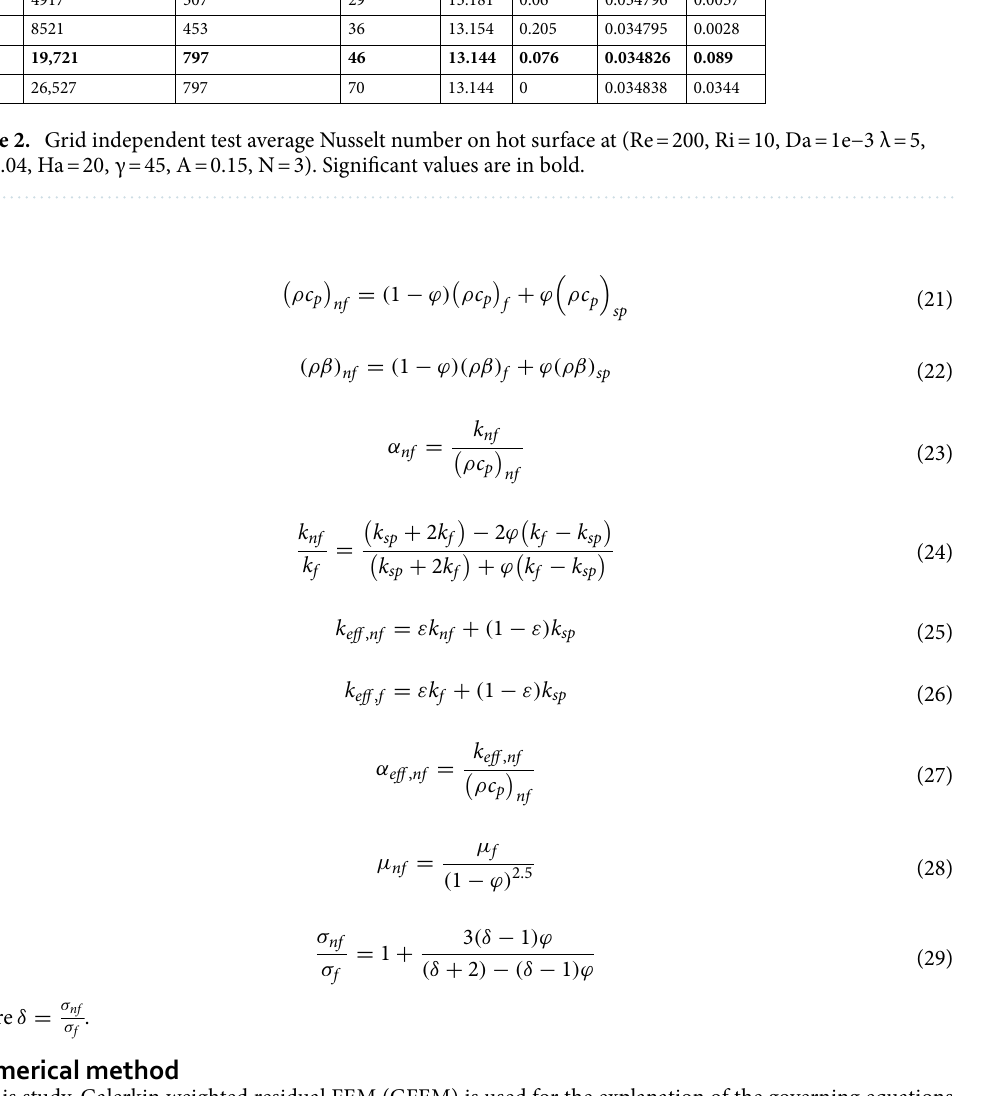
Grid Domain elements Boundary elements Time (sec) Nu ave